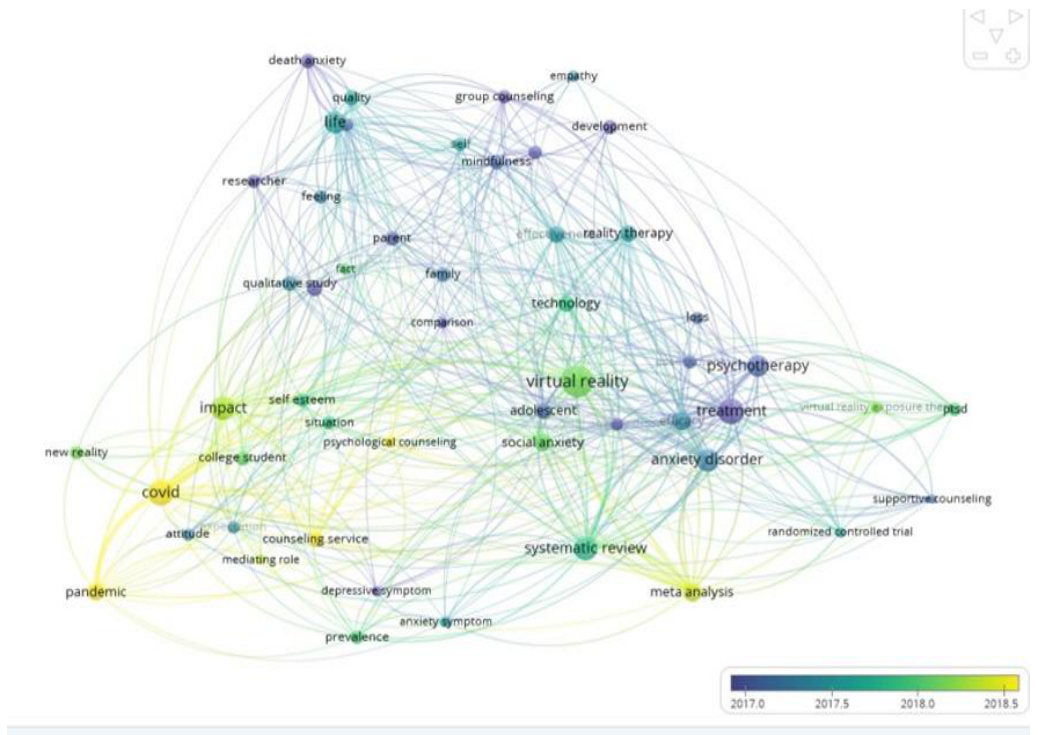
Figure 1 <Bibliometrics Using VOS